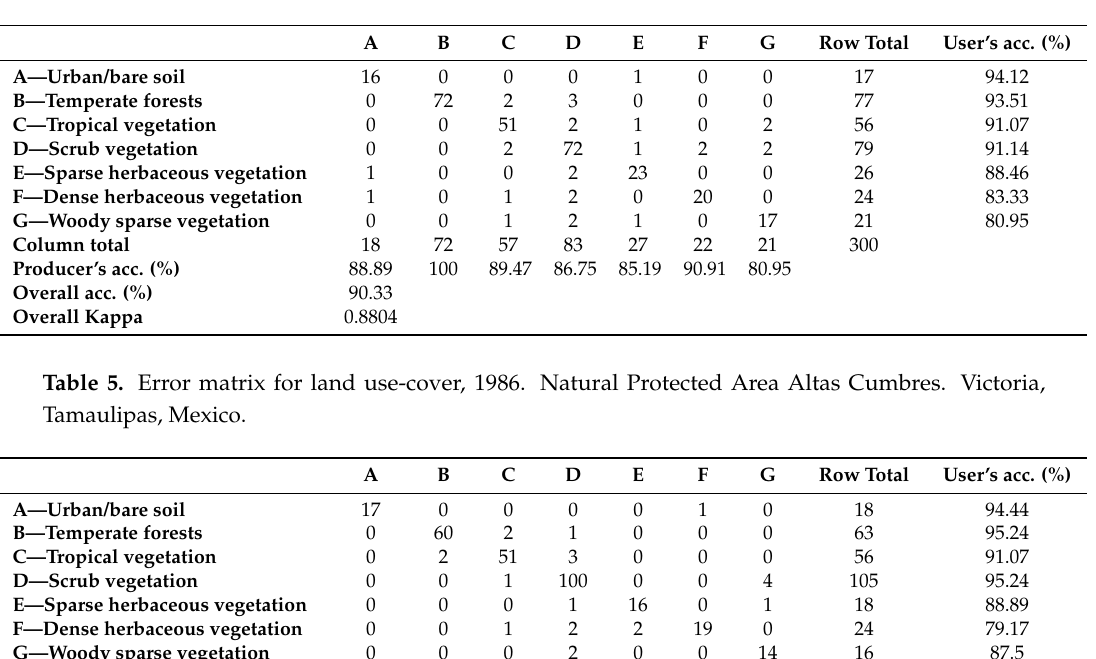
Table 4. Error matrix for land use-cover, 1973. Natural Protected Area Altas Cumbres. Victoria, Tamaulipas, Mexico.